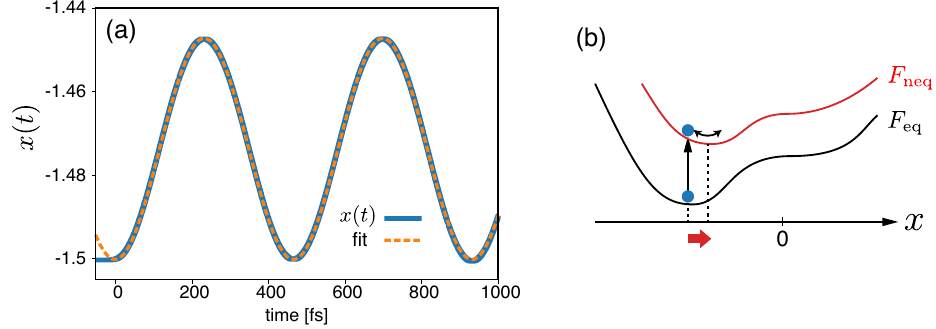
Figure 6. ( a ) time profile of lattice distortion x ( t ) (solid) and its sinusoidal fitting (dashed); ( b ) schematic illustration of mechanism of lattice dynamics x ( t )